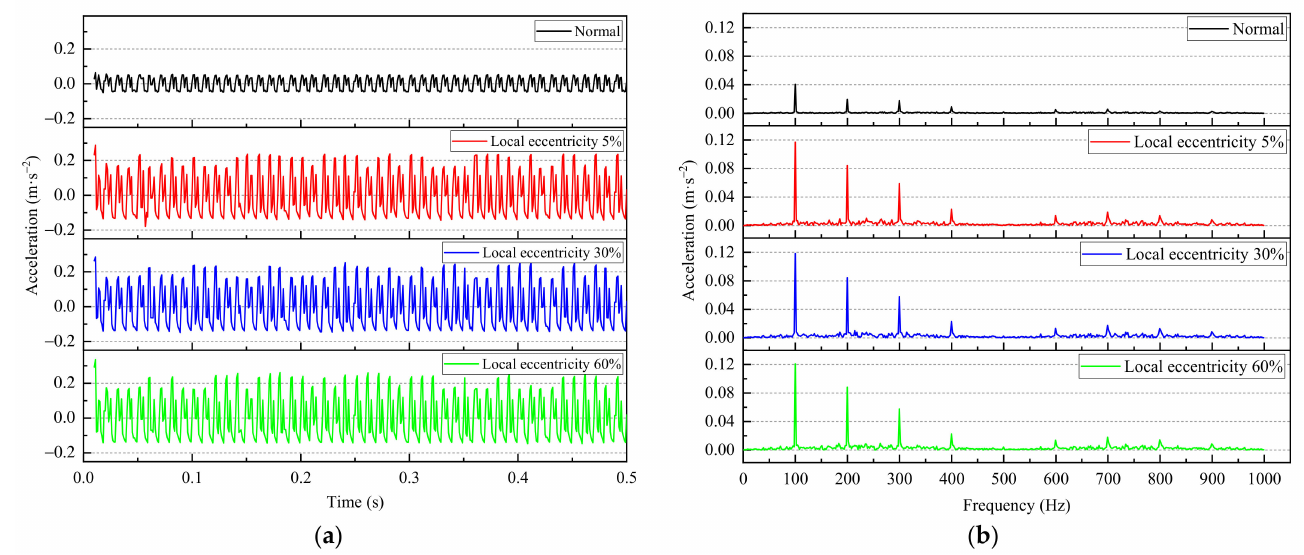
Figure 15. Acceleration signal at winding surface point 1 under normal and eccentric faults. ( a ) Ac- celeration time domain signal under normal and eccentric working conditions; ( b ) frequency domain signal of acceleration under normal and eccentric working conditions.